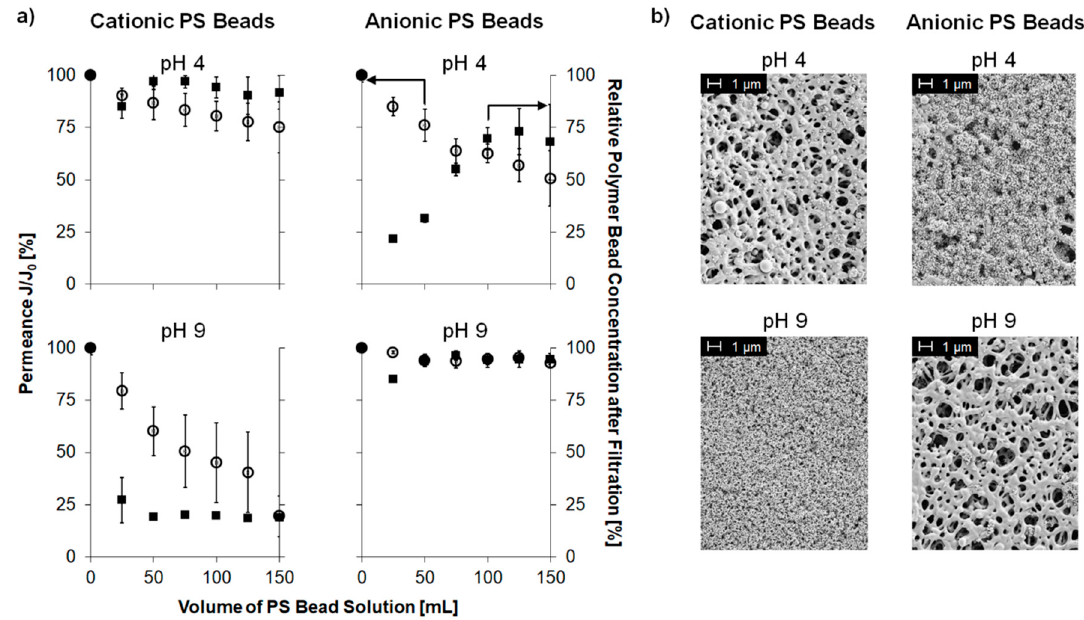
Figure 3. ( a ) Permeance J/J 0 (open circles, left axis) and relative PS bead concentration in the filtrate (full squares, right axis) of a polystyrene (PS) bead solution (cationic or anionic) filtered through a PES–Lysine membrane at pH value of 4 or 9, respectively; ( b ) SEM images of the membrane’s top side after filtration.